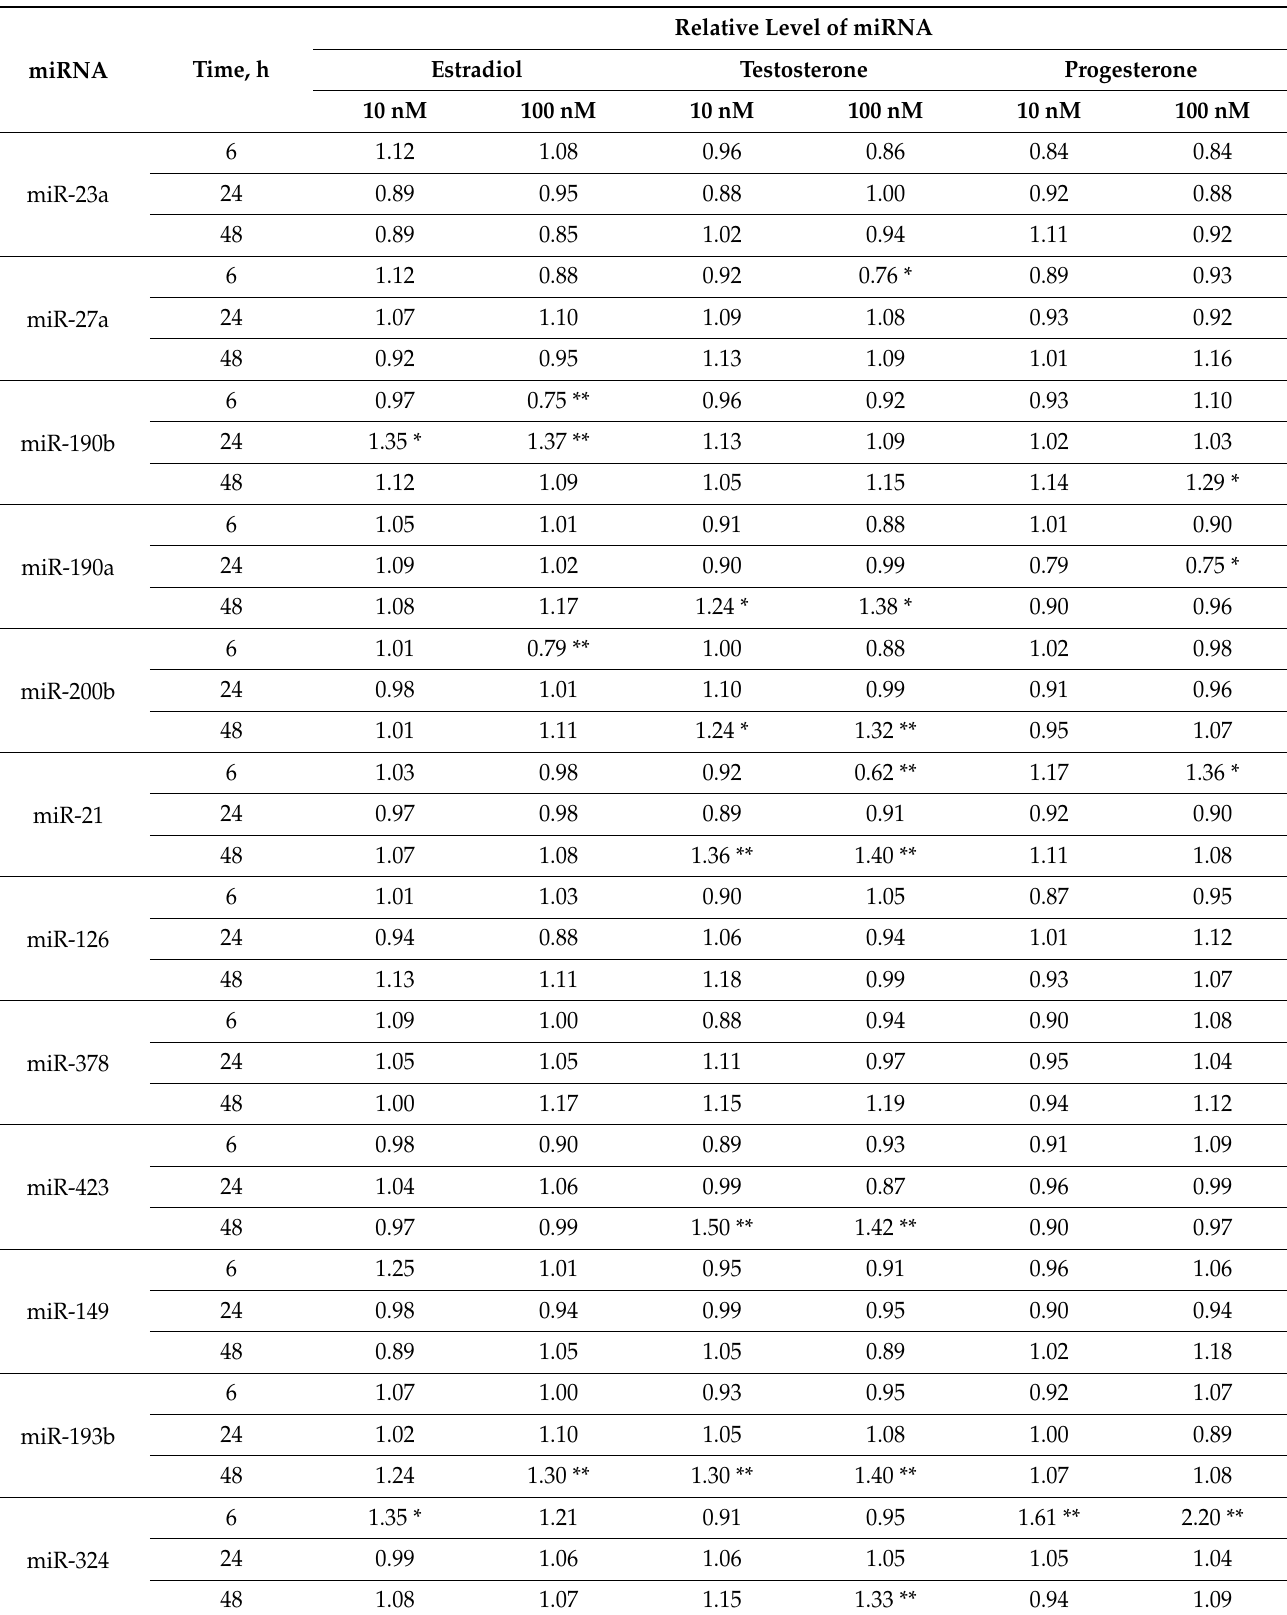
Table 3. Relative miRNA levels in MCF-7 cells treated with estradiol, testosterone, or